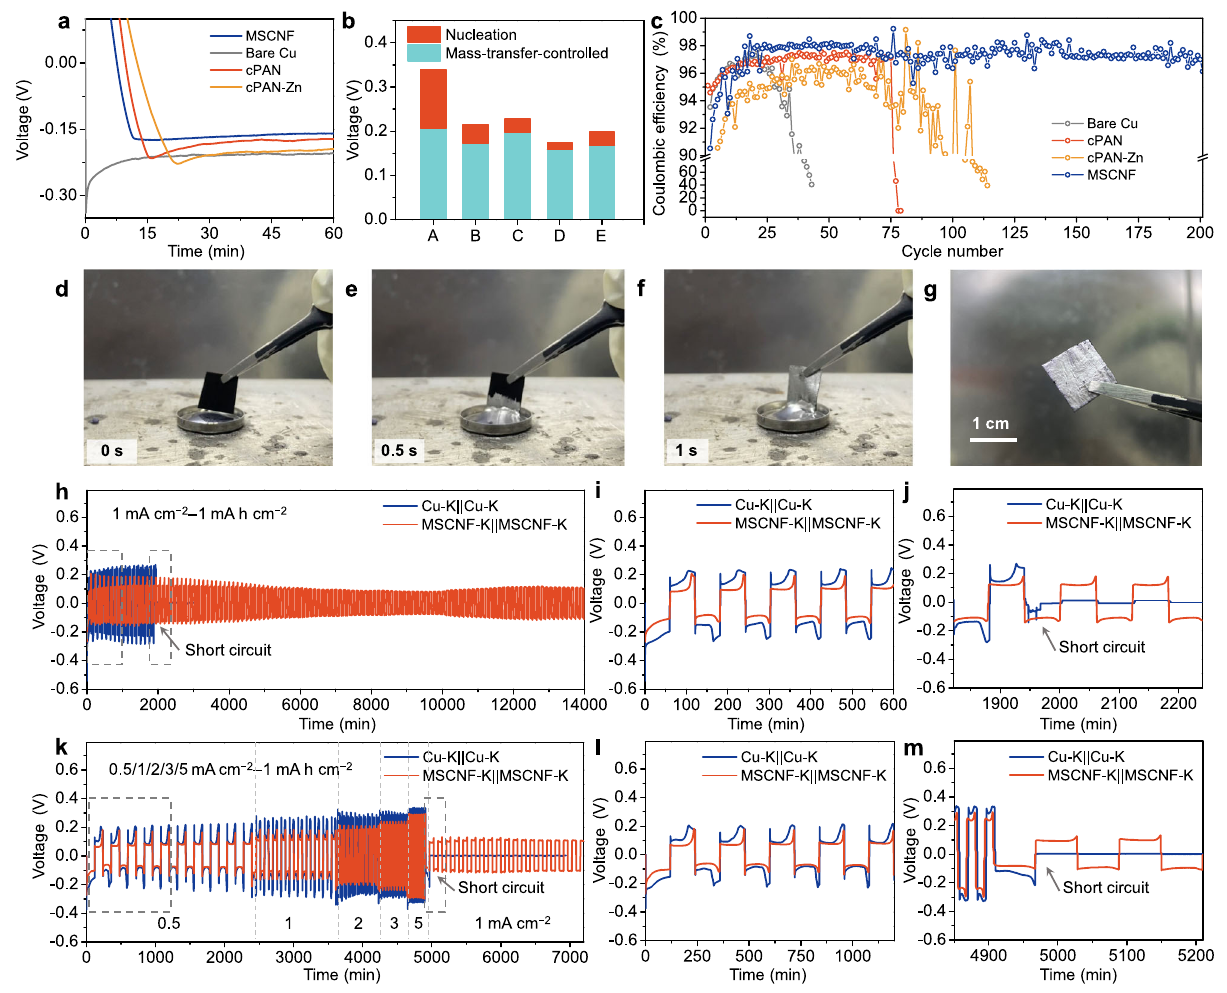
Fig. 2 | Electrochemical characterizations of various potassium metal hosts. a Voltage pro fi les of K nucleation on different hosts at a current density of 0.5mAcm − 2 . b Overpotentials of K deposition on different hosts (A: bare Cu, B: cPAN, C: cPAN-Zn, D: MSCNF, E: etched MSCNF). c Coulombic ef fi ciencies of K plating/strippingondifferenthostsatacurrentdensityof0.5mAcm − 2 . d – g Optical images of K infusion into MSCNFs and the corresponding product. h – j Voltage